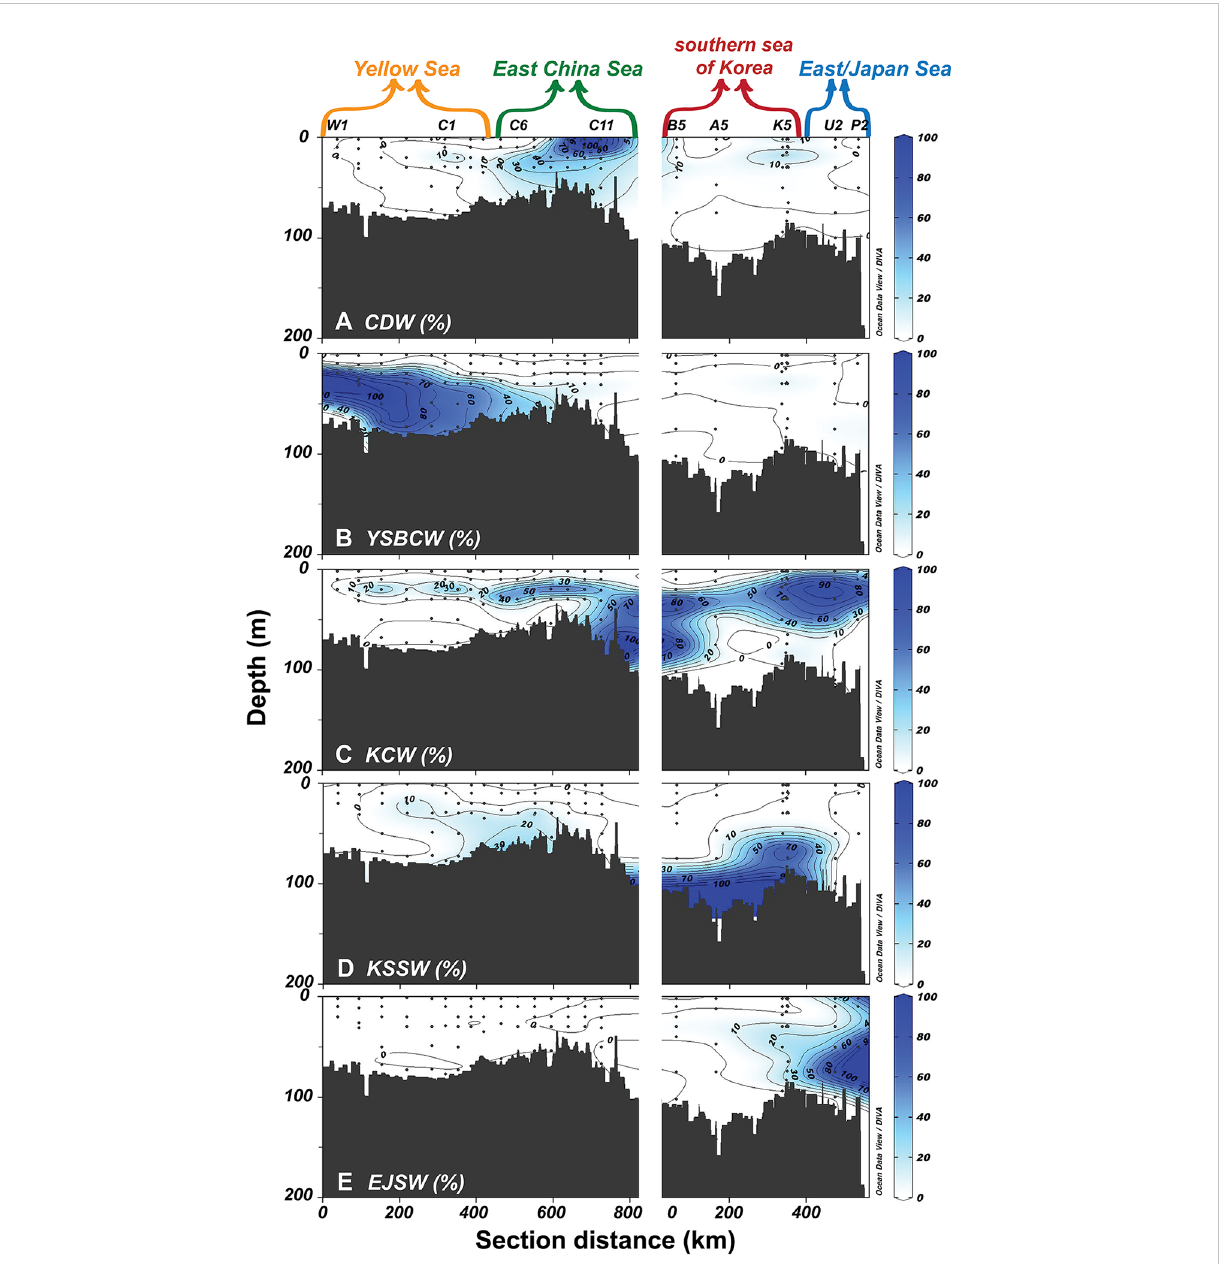
FIGURE 5 Distributions of SWTs in the northwestern Paci fi c marginal seas revealed by the OMP analysis along the transect shown in Figure 1: CDW (A) , YSBCW (B) , KCW (C) , KSSW (D) , and EJSW (E)